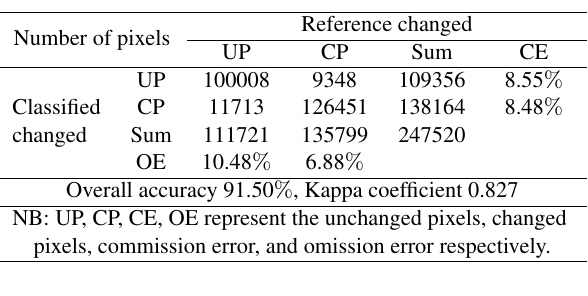
Table 3: Changed/unchanged confusion matrix for the sub-area in